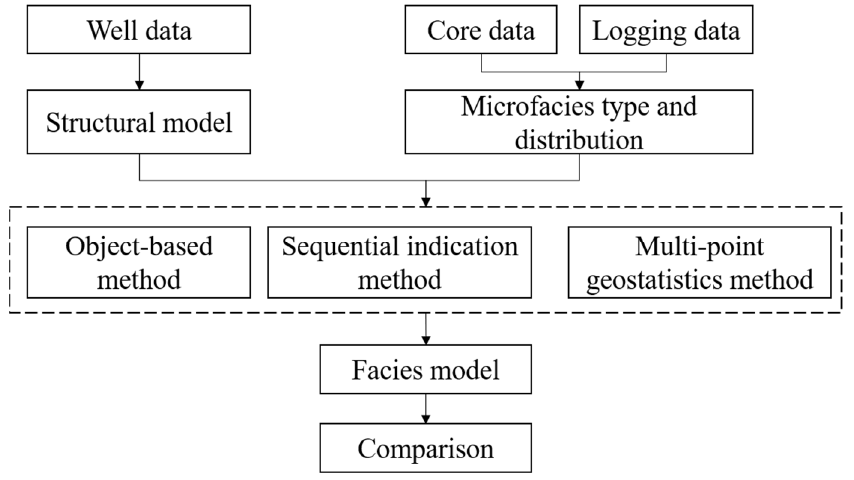
Figure 4. Workflow of creating facies model.